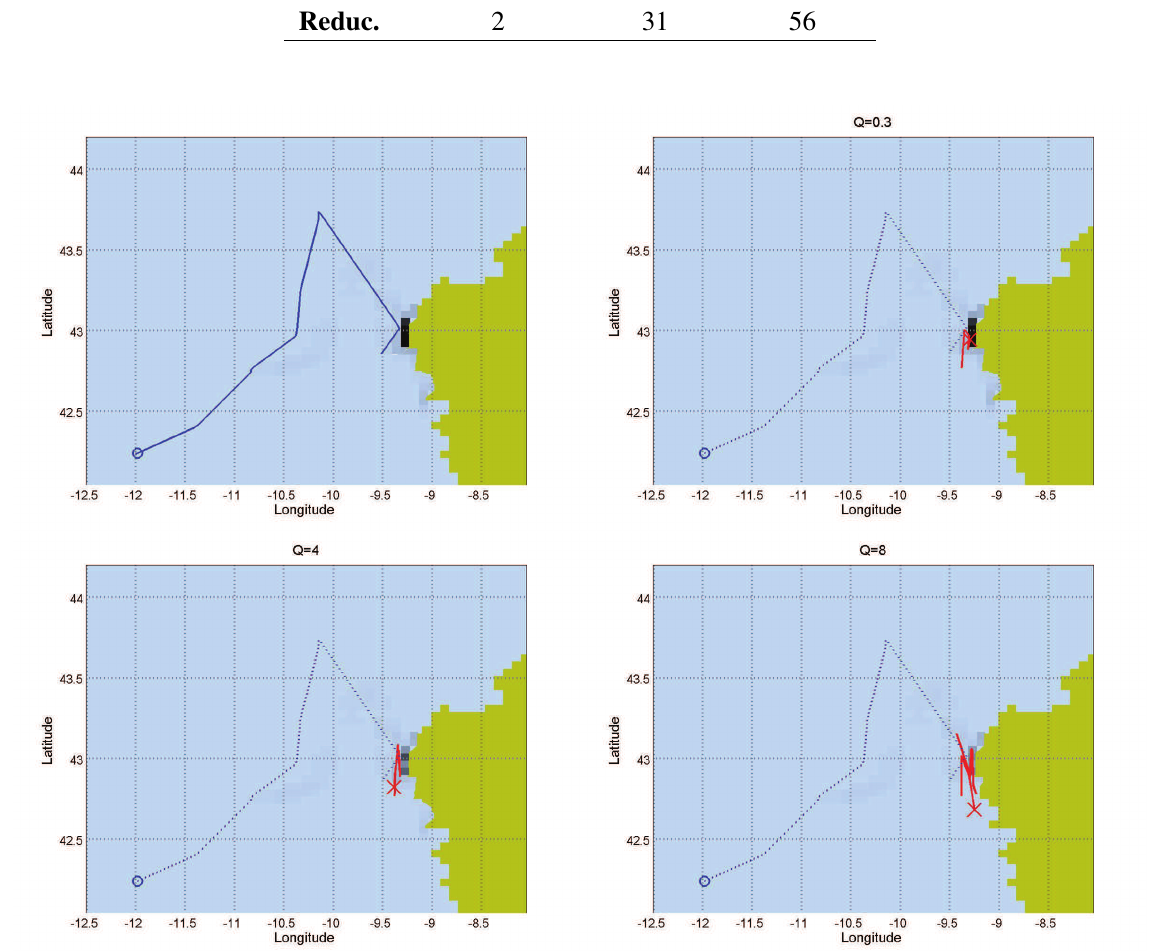
Fig. 7 Top view of the distribution c w , defined in Section 3.2.2, on 19 2002, skimmer ship trajectory (continuous red line), final position of the skimmer ship (x); final position of the Prestige ship (o) for the experiments: ( Top-Left ) trajectory of the Prestige ship (continuous blue line) with no pumping process, ( Top-Right ) OPT-0.3- (4), ( Bottom-Left ) OPT-4- (4) and ( Bottom Right ) OPT-8- (4). The trajectory of the Prestige ship is also presented in dotted blue